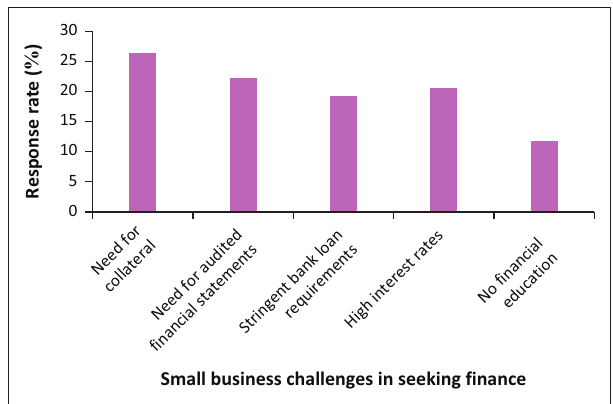
FIGURE 1: Sources of small business funding. In South Africa, most of the small businesses are funded from personal savings.